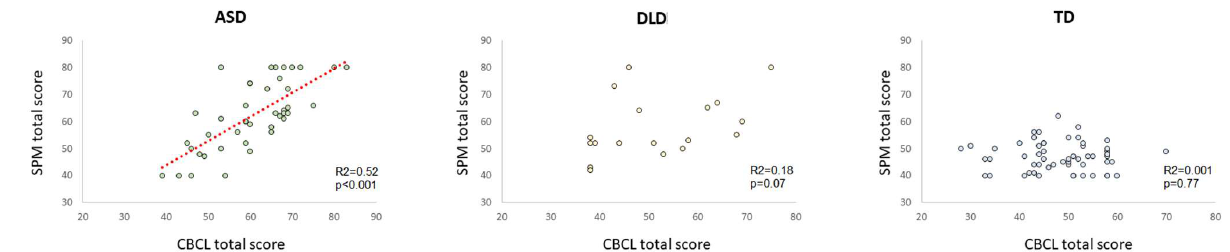
Figure 2. The left panel reports the linear regression analysis between SPM total scores and CBCL 1½-5 total scores for ASD children. Dots represent individual participants; the significant linear trend is reported as the red dotted line. R and p values are indicated on the bottom right. The middle and the right panel’s report the same data for DLD and TD groups. For the convenience of the reader, y-axes have been kept homogeneous.